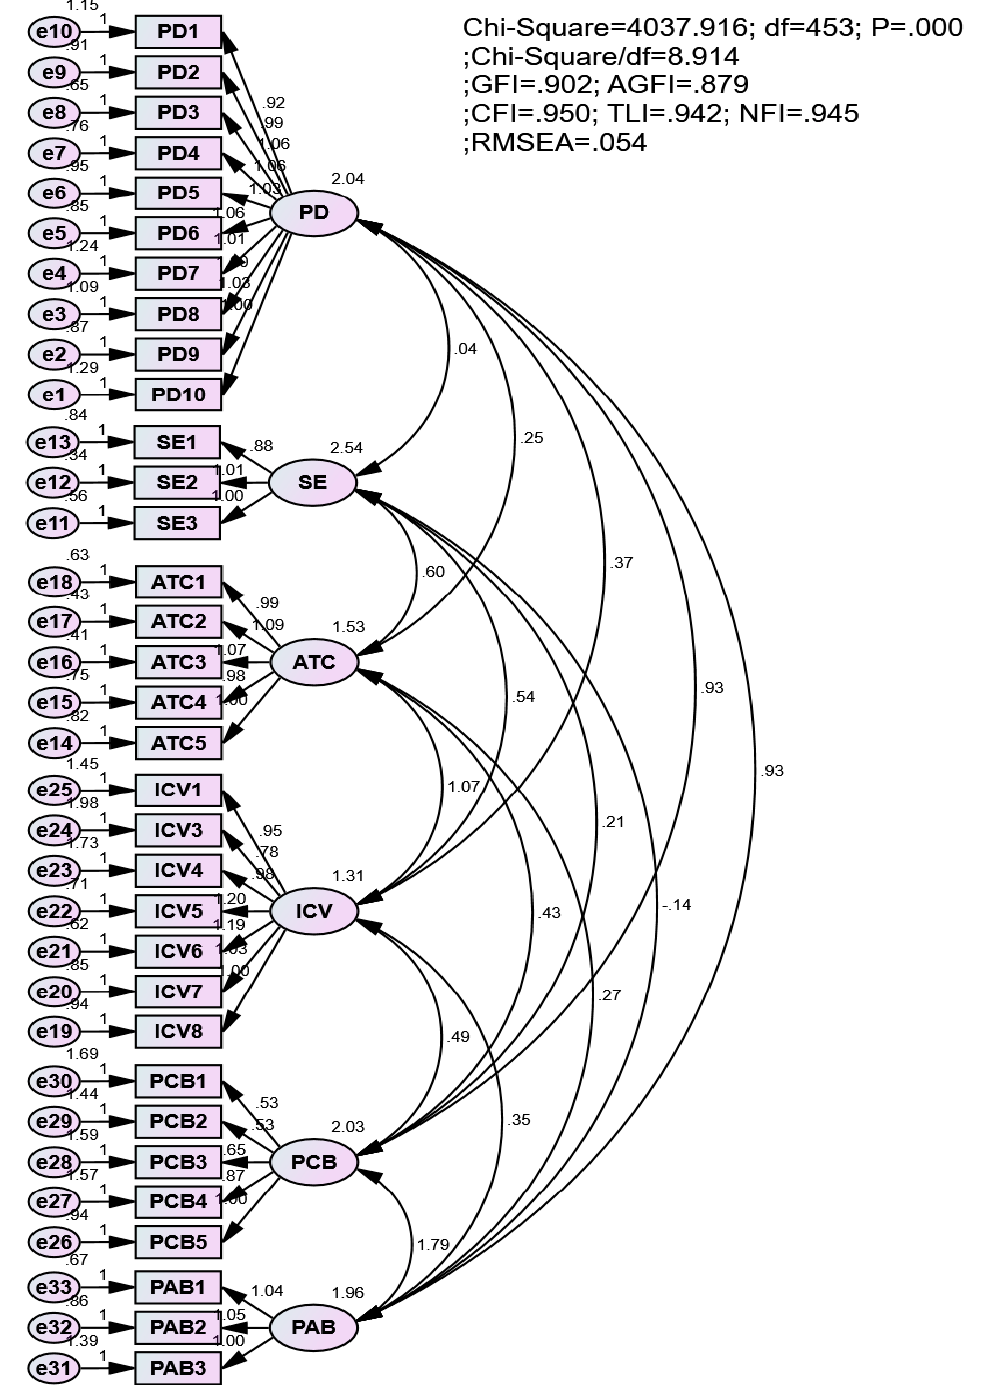
Figure 2. Measurement model. Table 4 reveals the correlations of constructs. First, results indicated that intention to receive COVID-19 vaccines was positively correlated with attitudes towards COVID-19 vaccines ( γ = 0.623; p -value < 0.001), self-efficacy ( γ = 0.060; p -value < 0.001) and perceived clinical barriers ( γ = 0.142; p -value < 0.001), yet it was negatively influenced by perceived access barriers ( γ = − 0.445; p -value < 0.001). Second, self-efficacy was found to have a significant effect on attitudes towards COVID-19 vaccines ( γ = 0.158; p -value < 0.001). Third, while perceived clinical barriers were positively associated with self-efficacy ( γ =